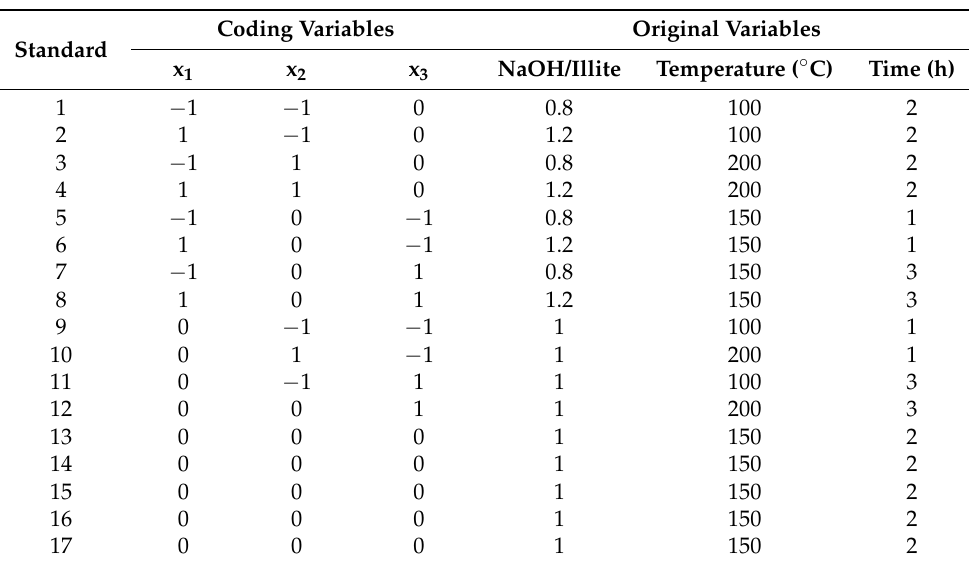
Table 2. Box-Behnken experimental design matrix with original and coded